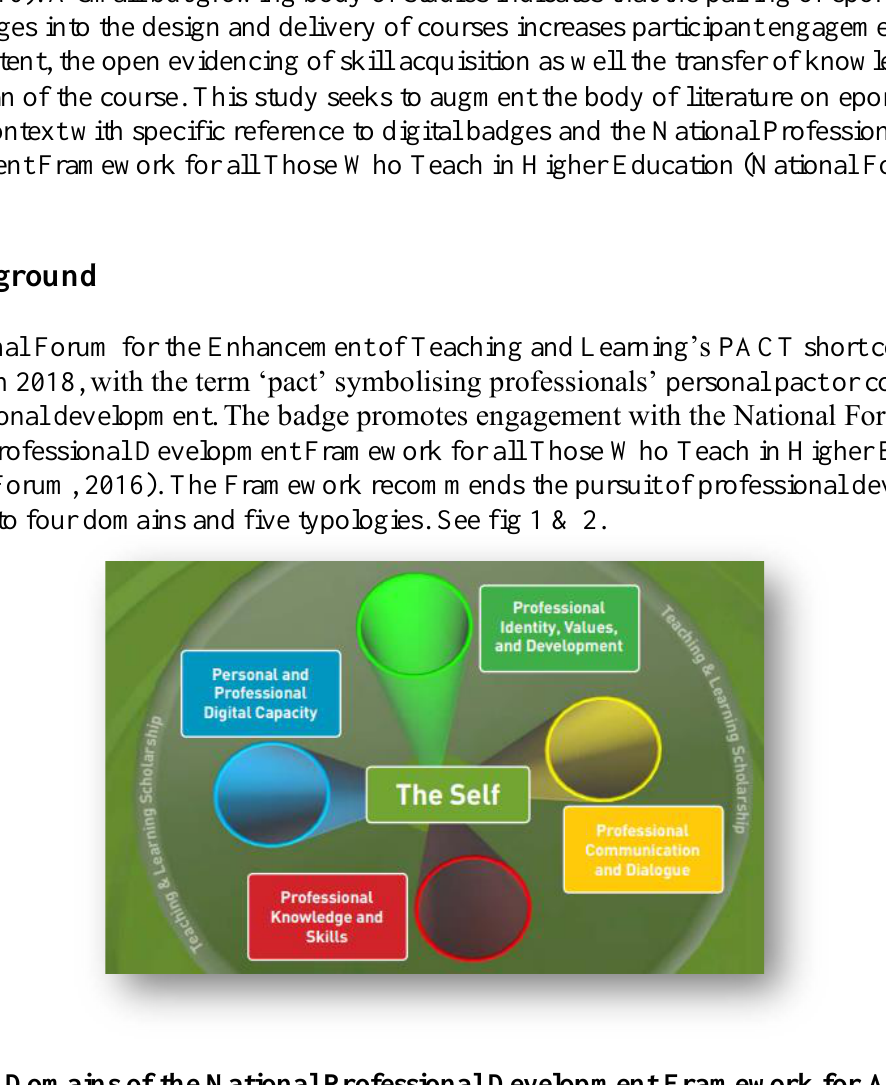
Fig. 1 The Domains of the National Professional Development Framework for All Those Who Teach in Higher Education (National Forum, 2016,